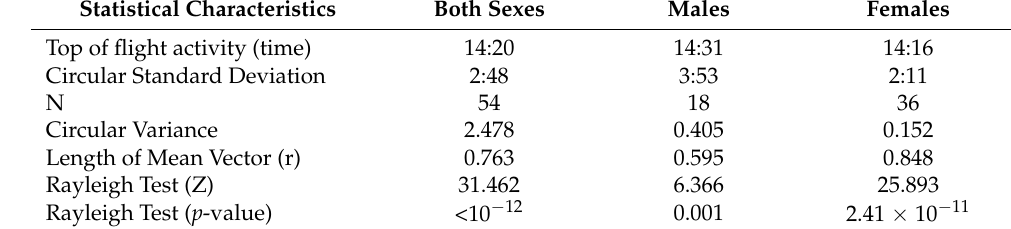
Table 1. Results of diurnal flight activity for the species, and separately for males and females (2013).